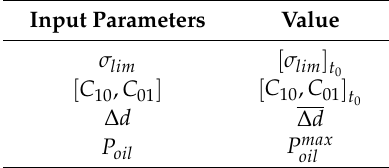
Table 2. Input parameters in the